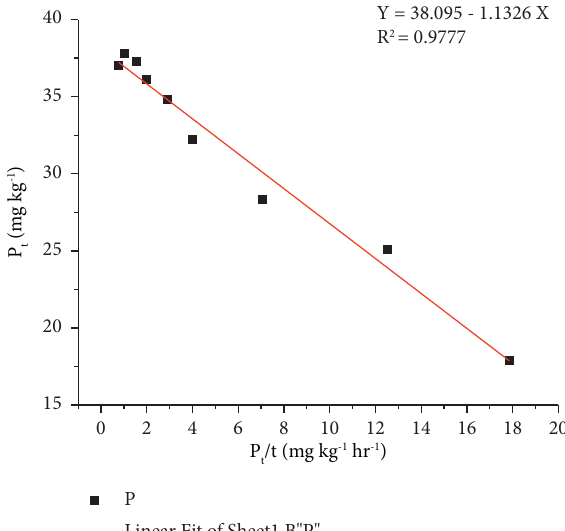
Figure 6: Experimental kinetic plot and fitting corresponding to the pseudo-second-order kinetic equation for the sorption of phosphate onto the soil chosen from Meupi West Table 3: Pearson product moment correlations between some important soil physicochemical properties.